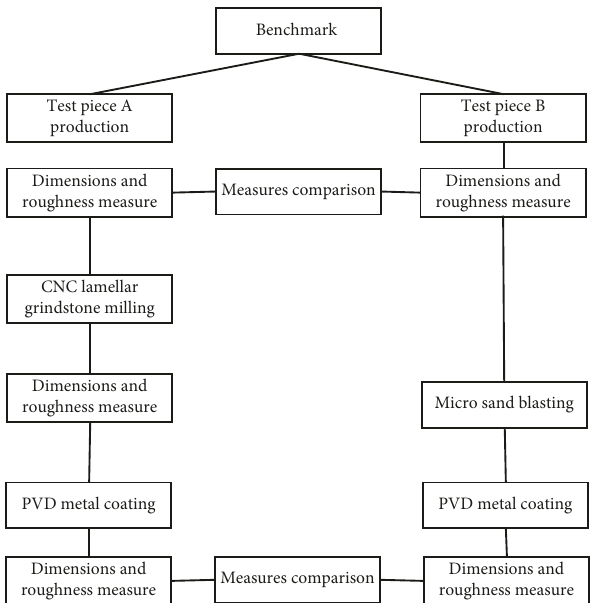
Figure 2: Flowchart of